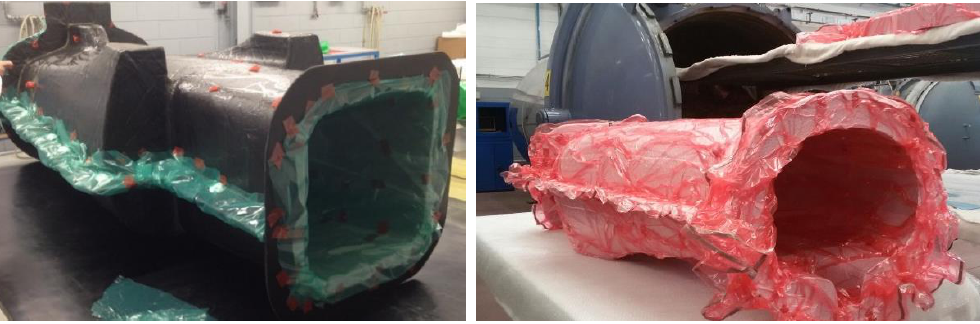
Figure 14. Final central part . Figure 15 . Full vehicle body assembled . 4. Discussion Mass reduction is a key factor in the design of a prototype vehicle aimed at a low consumption competition, such as the Shell Eco-marathon. In this paper, the structural design of IDRAkronos prototype's body, from the concept phase (Figure 3) to the manufacturing process (Figure 15) was